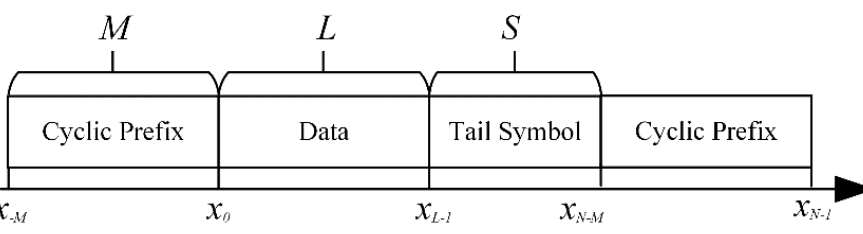
Figure 2. Complete frame structure.